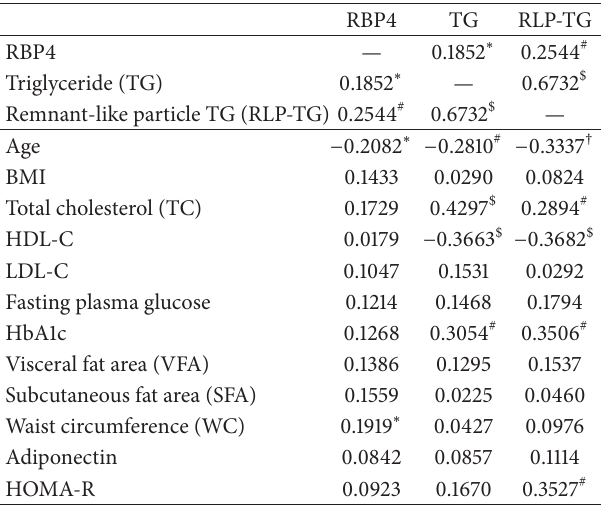
Table 2: Pearson correlation coefficients in the 92 patients with type 2 diabetes mellitus.